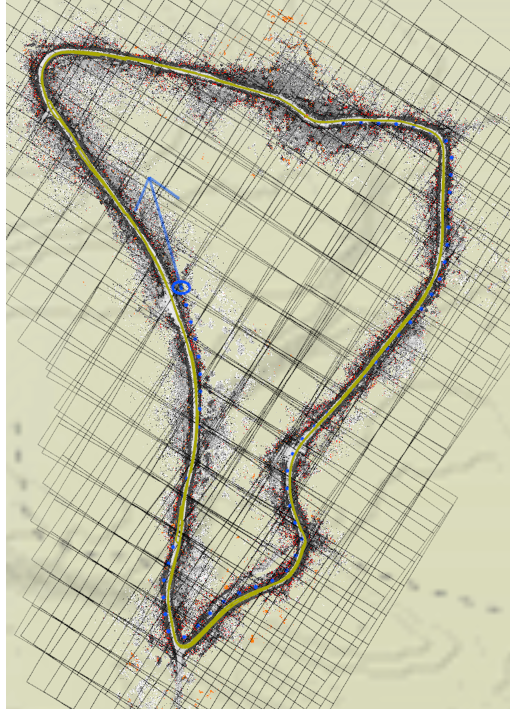
Figure 5. A map of a 1.2 km trail. This was created by one traversal of the loop with GPS, and about one and half more without GPS. The blue arrow represents the estimated location of the vehicle at the point where the map was saved, and the blue dots a location